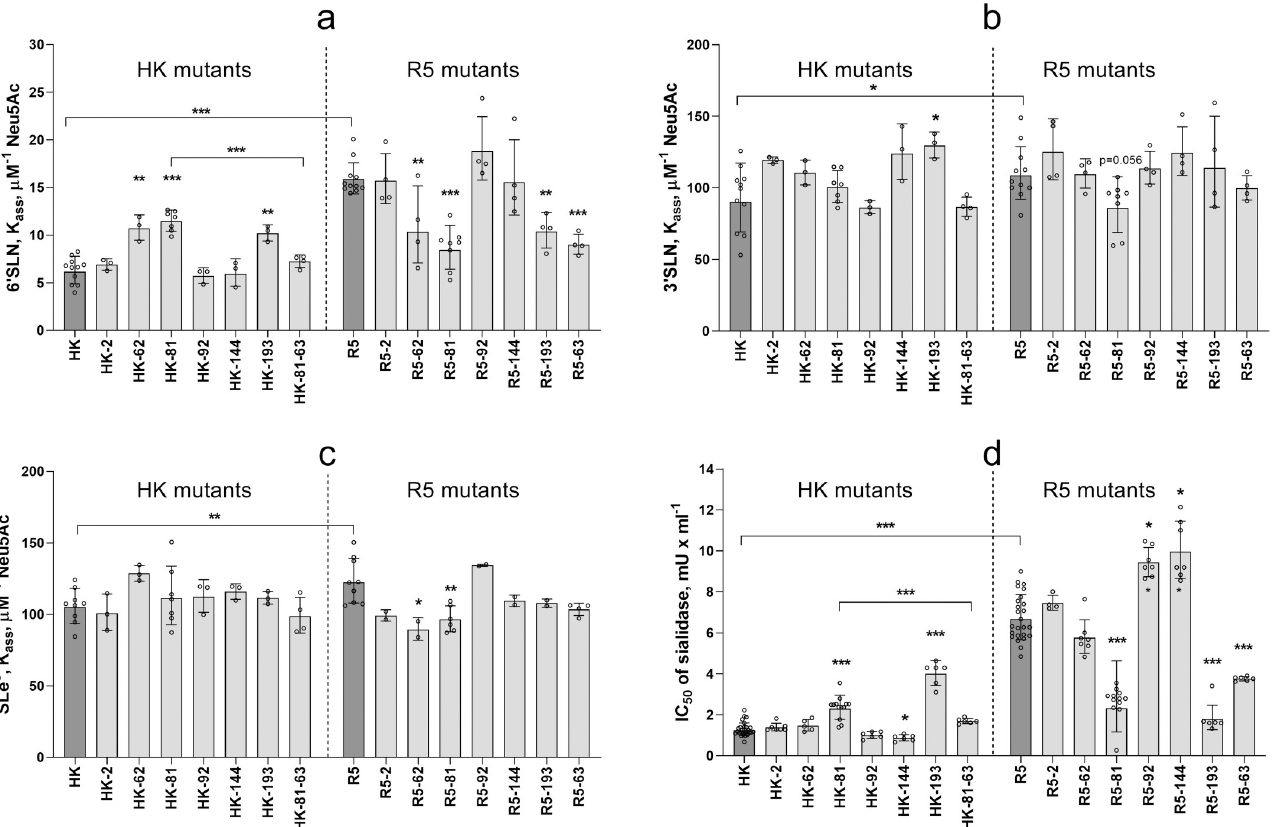
Fig 4. Receptor-binding properties of HA point mutants of HK and R5. ( a-c ) Association constants of viral complexes with biotinylated SGPs 6’SLN (20 kDa), 3’SLN and SLe c (both 1 MDa) were determined as described in Materials and Methods. Data represent combined results from 4 to 11 experiments performed on different days with 1 replicate for each virus-SGP pair per experiment. ( d ) Inhibition of viral cell entry by Vibrio cholerae sialidase. MDCK cells were incubated with solutions of gradually diluted sialidase for 30 min, inoculated with 200 FFU of the viruses without removing sialidase, fixed after one cycle of replication and immunostained for viral NP. The figure shows concentrations of sialidase that reduced numbers of infected cells by 50% (IC 50 ). From 2 to 9 experiments were performed on different days using 3 to 4 replicates per virus. All panels show the individual values adjusted for day as described in Materials and Methods with geometric mean (bars) and SDs. Vertical dotted line separates point mutants of HK and point mutants of R5. Asterisks depict P values for the differences between single-point mutants and the corresponding parental virus, either HK or R5 (dark gray bars). Asterisks over horizontal lines depict differences between HK and R5 and between HK-81 and